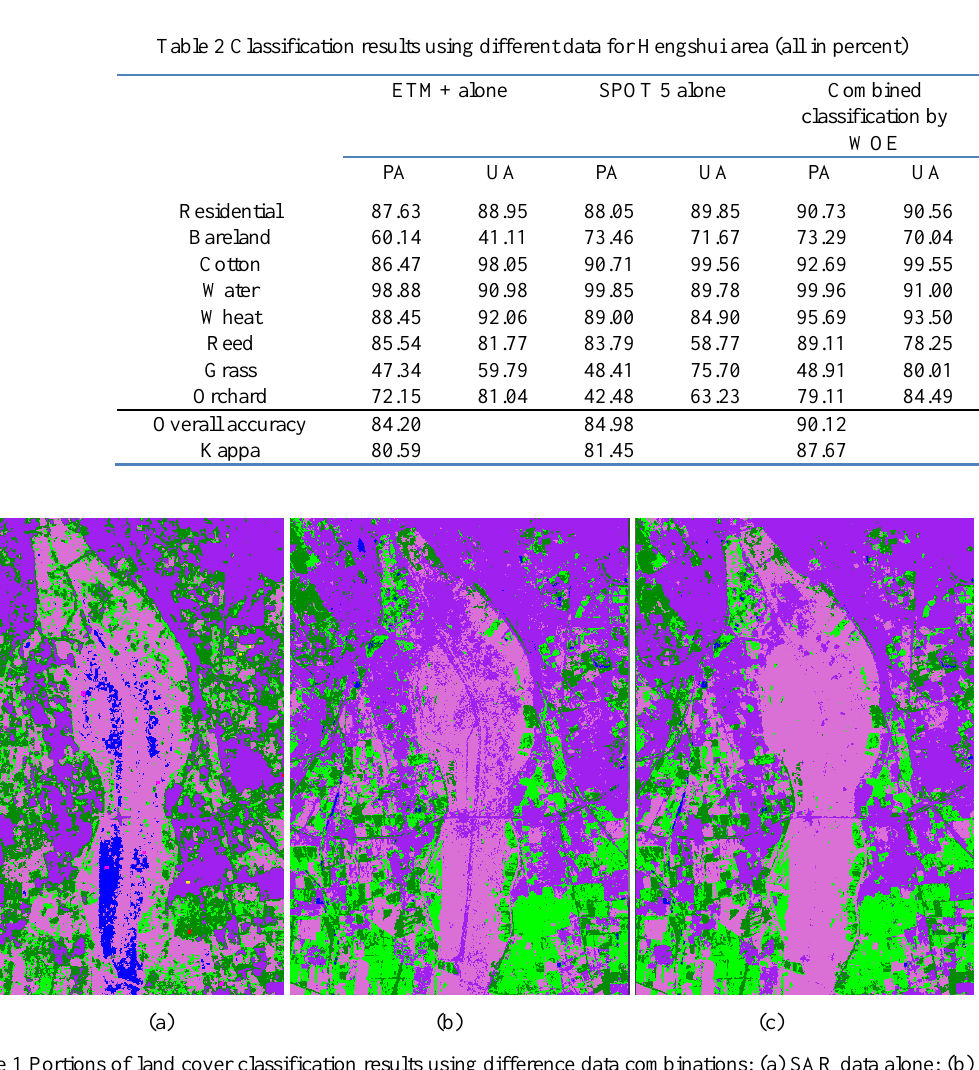
Figure 1 Portions of land cover classification results using difference data combinations: (a) SAR data alone; (b) Landsat TM alone; (c) Combined TM and SAR data using